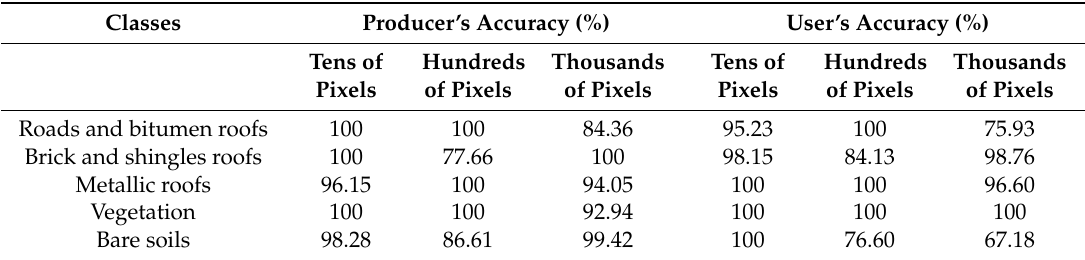
Table 2. ROI-based SAM classification accuracy at different numbers of training sample pixels. Producer’s Accuracy (%) and User’s Accuracy (%).